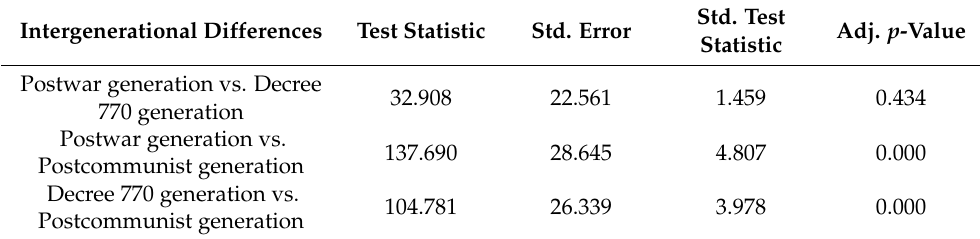
Table 3. Pairwise comparisons between the three generations.